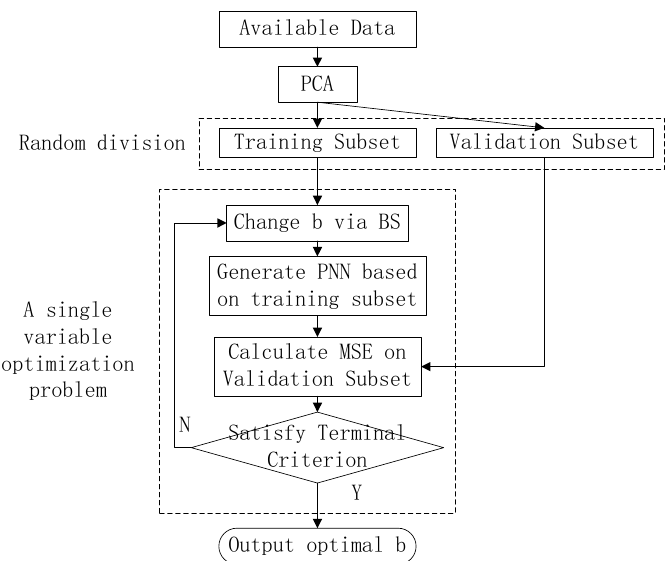
Figure 2. The outline of our